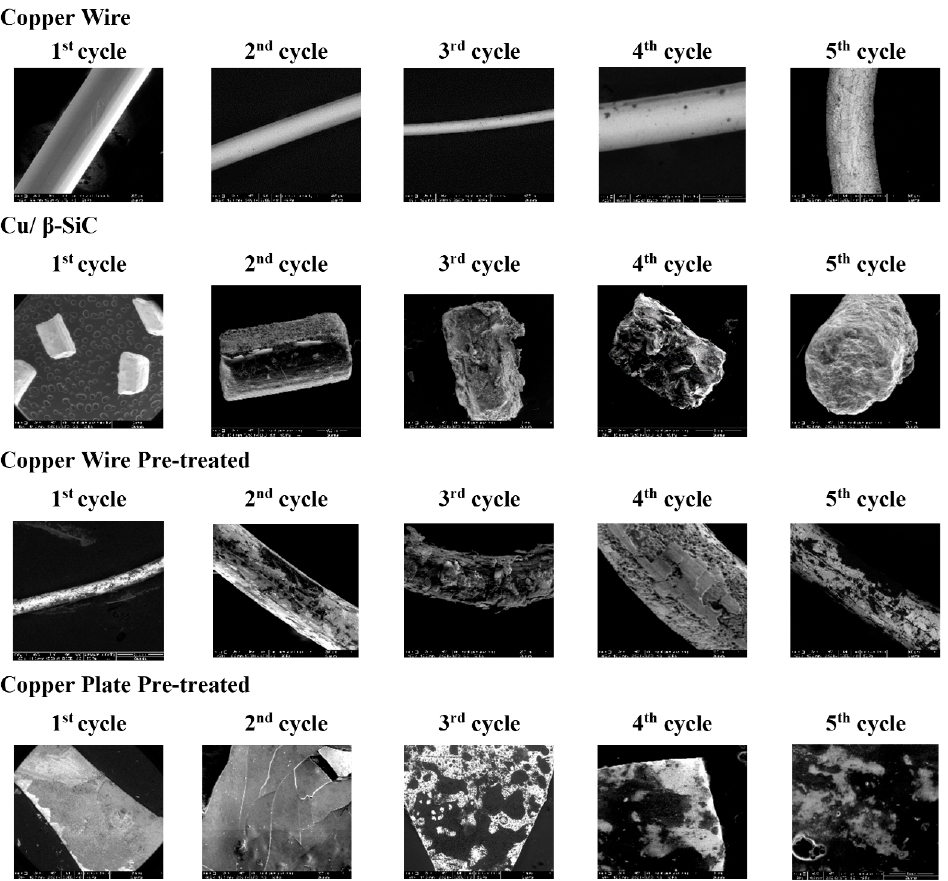
Figure 7. SEM images of heterogeneous catalysts in scCO 2 as solvent after five cycles. The images of Cu/ β -SiC pellets show how the product adheres to the pellet, making it hard to clean the catalyst for another cycle. The pre-treated catalysts exhibited severe weathering and considerable changes in their structures. In fact, the SEM images showed the weathering and fracture of the copper plate from the second cycle onwards and from the third cycle for copper wire. 3. Materials and Methods 3.1. Materials The following materials were used to carry out the different syntheses: AMMC (syn- thesis was published in the literature [49–52]) and methoxy mPEG-alkyne 2000 g/mol (Specific Polymers, Castries, France) were used without further purification. Copper wire with a diameter 0.25 mm, plates of copper with a thickness of 2 mm, copper (II) acetate monohydrate and copper (I) bromide were obtained from Sigma Aldrich ( Spanish division, Madrid, Spain ). Silicon carbide pellets were purchased of SICAT (Strasbourg, France). The solvents used were THF, toluene, and PMDTA which were obtained from Sigma-Aldrich. Carbon dioxide was provided by Air Liquide, Spain, with a purity of 99.8%. 3.2. Synthesis of Click Product in scCO 2 . Amounts of 0.05 mmol of mPEG-alkyne and 0.05 mmol of AMMC were introduced together with the corresponding amount of catalyst in a high-pressure reactor, in the ab- sence of ligands. Once the reactor was hermetically sealed, scCO 2 was pumped out until